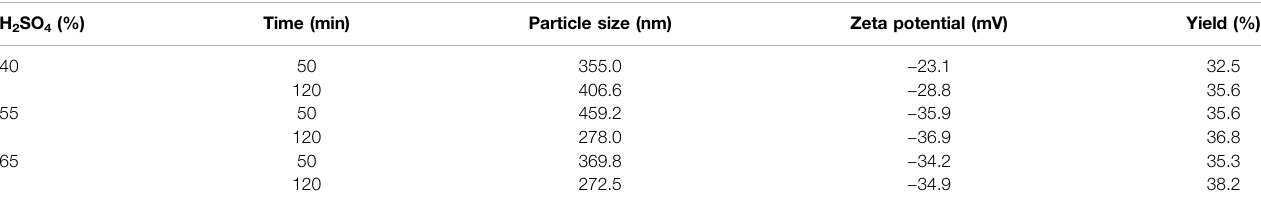
TABLE 4 | Particle size, zeta potential, and yield of CNCs at RT. H 2 SO 4